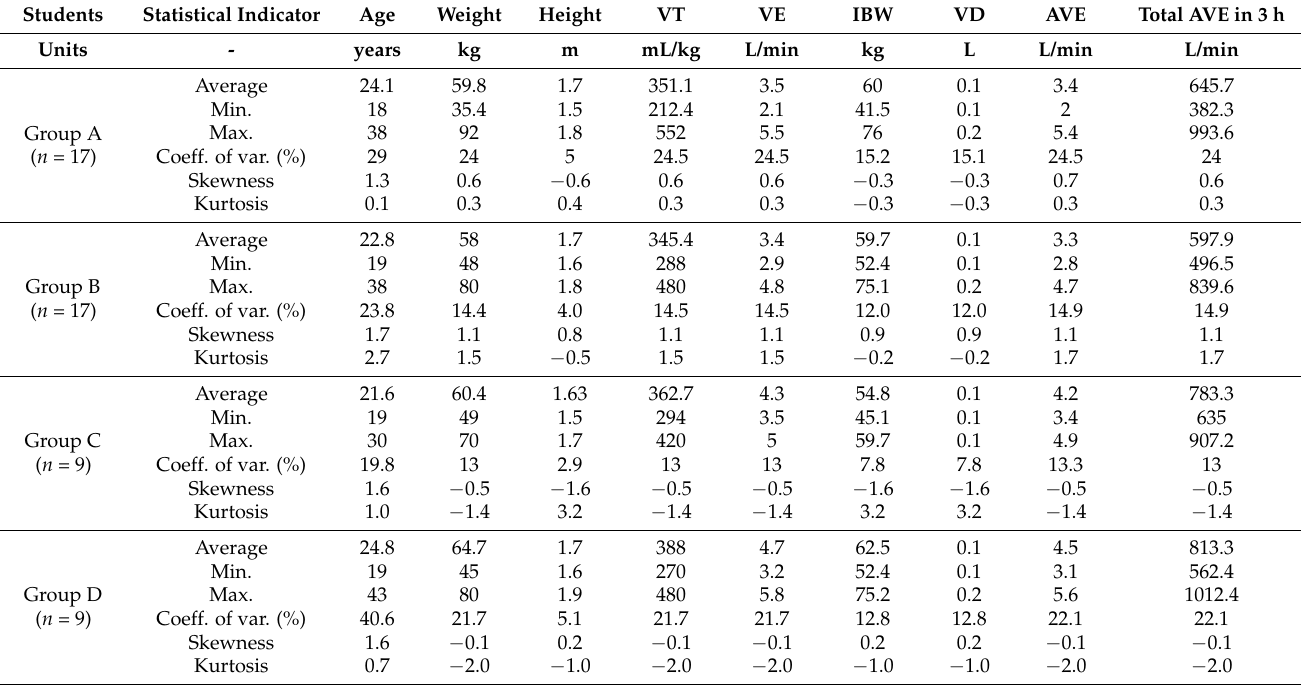
Table 6. Variability of functional probes and respiratory characteristics between the groups of